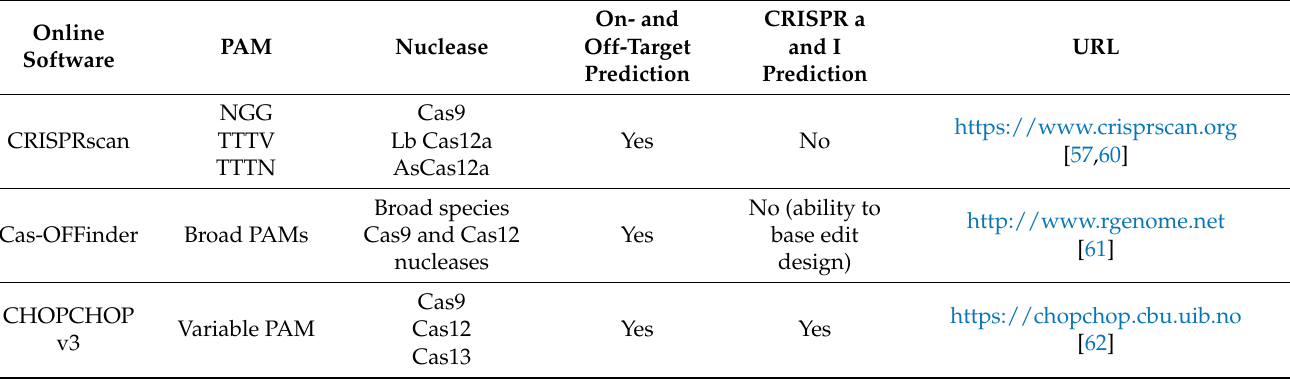
Table 2. List of software tools available for CRISPR sgRNA